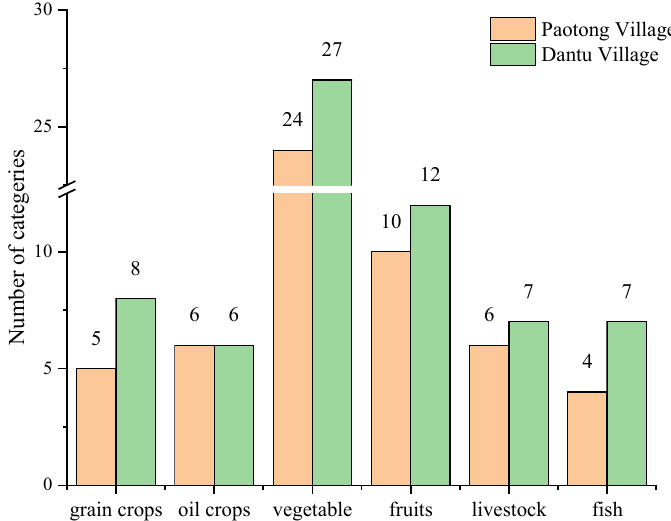
Figure 10. The agricultural biodiversity in two case-study sites.